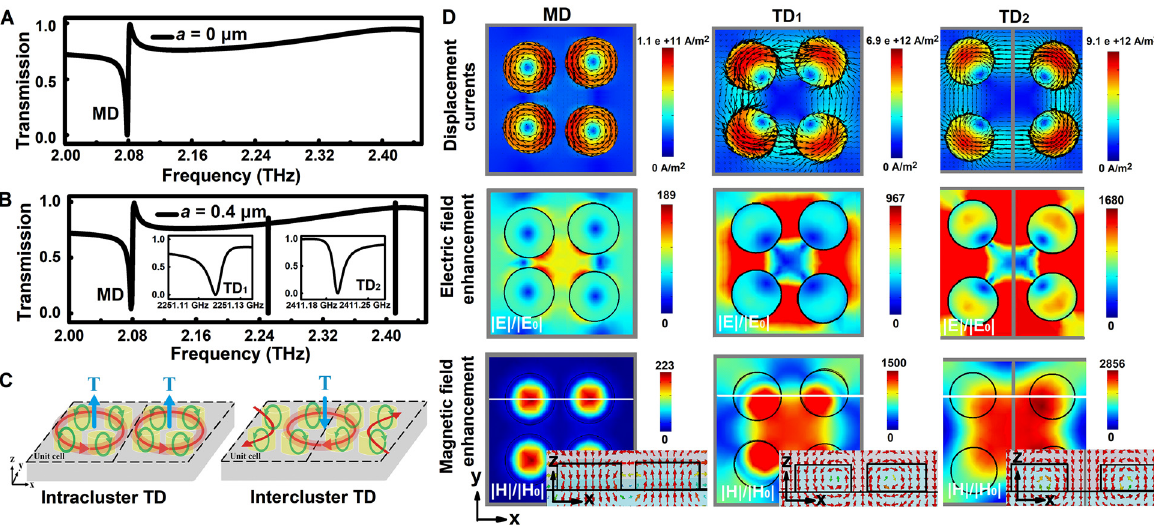
Figure2: Transmissionspectraofthemetasurfacewithanasymmetricparameter(A) a =0 μ mand(B) a =0.4 μ m,theinsetsarelargerversions of transmission spectra for TD 1 and TD 2, respectively. (C) The conceptual descriptions of intracluster TD and intercluster TD, the dashed box indicates the unit cell of the metasurface, the green circles with arrows show the magnetic fi eld, the red circles with arrows represent the displacement currents, and the blue arrows are the excited TD moments. (D) Cross-sectional patterns of displacement currents (arrows representthedirectionsofdisplacementcurrents),electric fi eldenhancement,andmagnetic fi eldenhancementatthethreeresonancesinthe x – y plane with z -axis corresponding to the half-height of the cylinder. The insets in (D) show the cross-sectional patterns of magnetic fi eld in x – y plane with y -axis corresponding to the position of white line in the distribution of the magnetic fi eld enhancement in the x – y plane, the red arrows show the directions of magnetic fi eld. The gray line refers to the boundary of the two neighboring